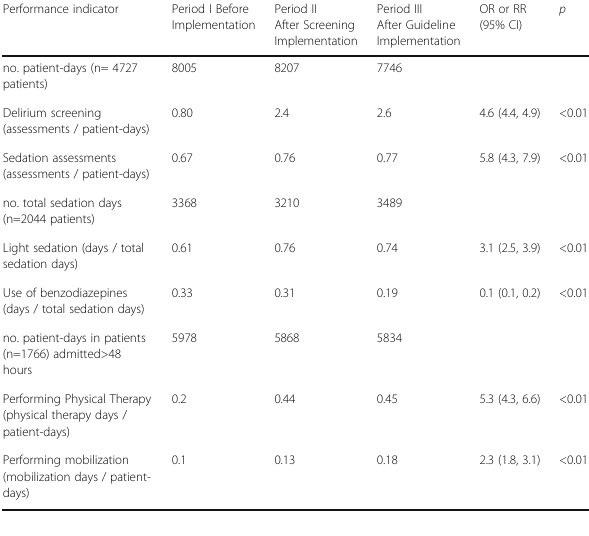
Table 19 (abstract A33). Adherence to guideline